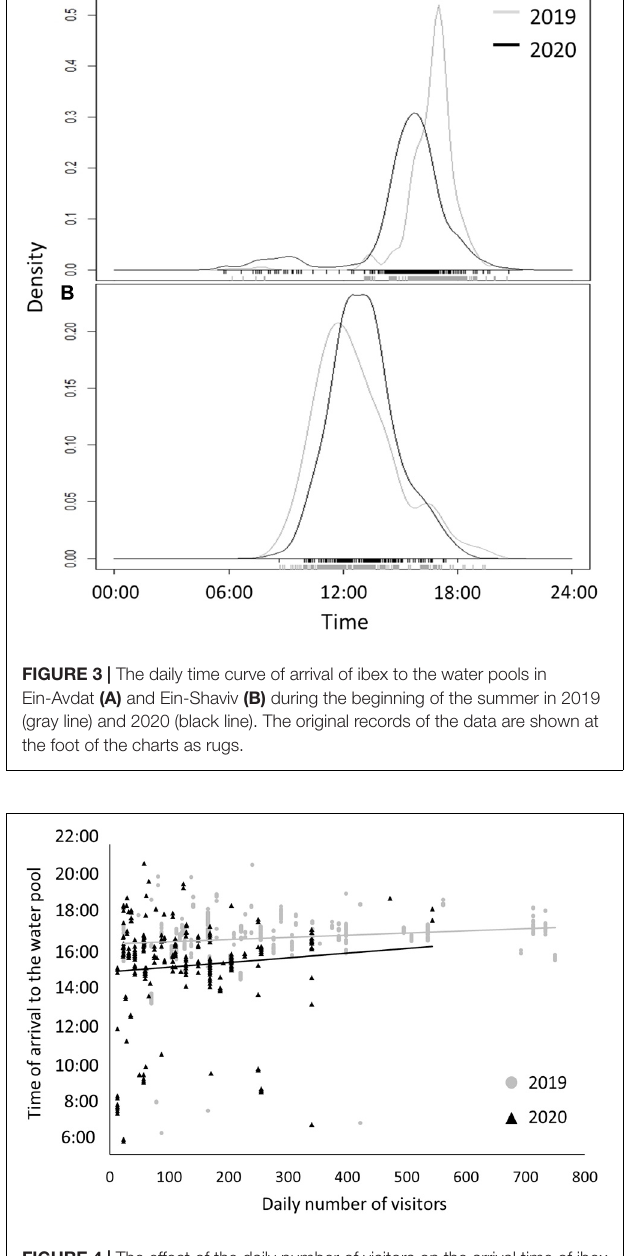
FIGURE 4 | The effect of the daily number of visitors on the arrival time of ibex to the water pool in Ein-Avdat during 2019 (gray circles) and 2020 (black